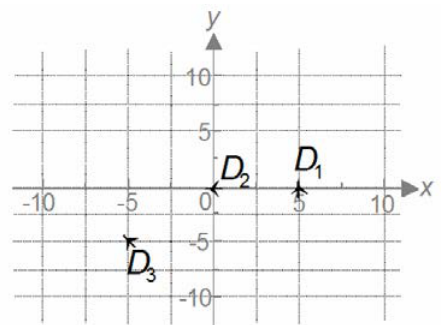
Figure 14: Assumed configuration of the set of three electric dipoles.